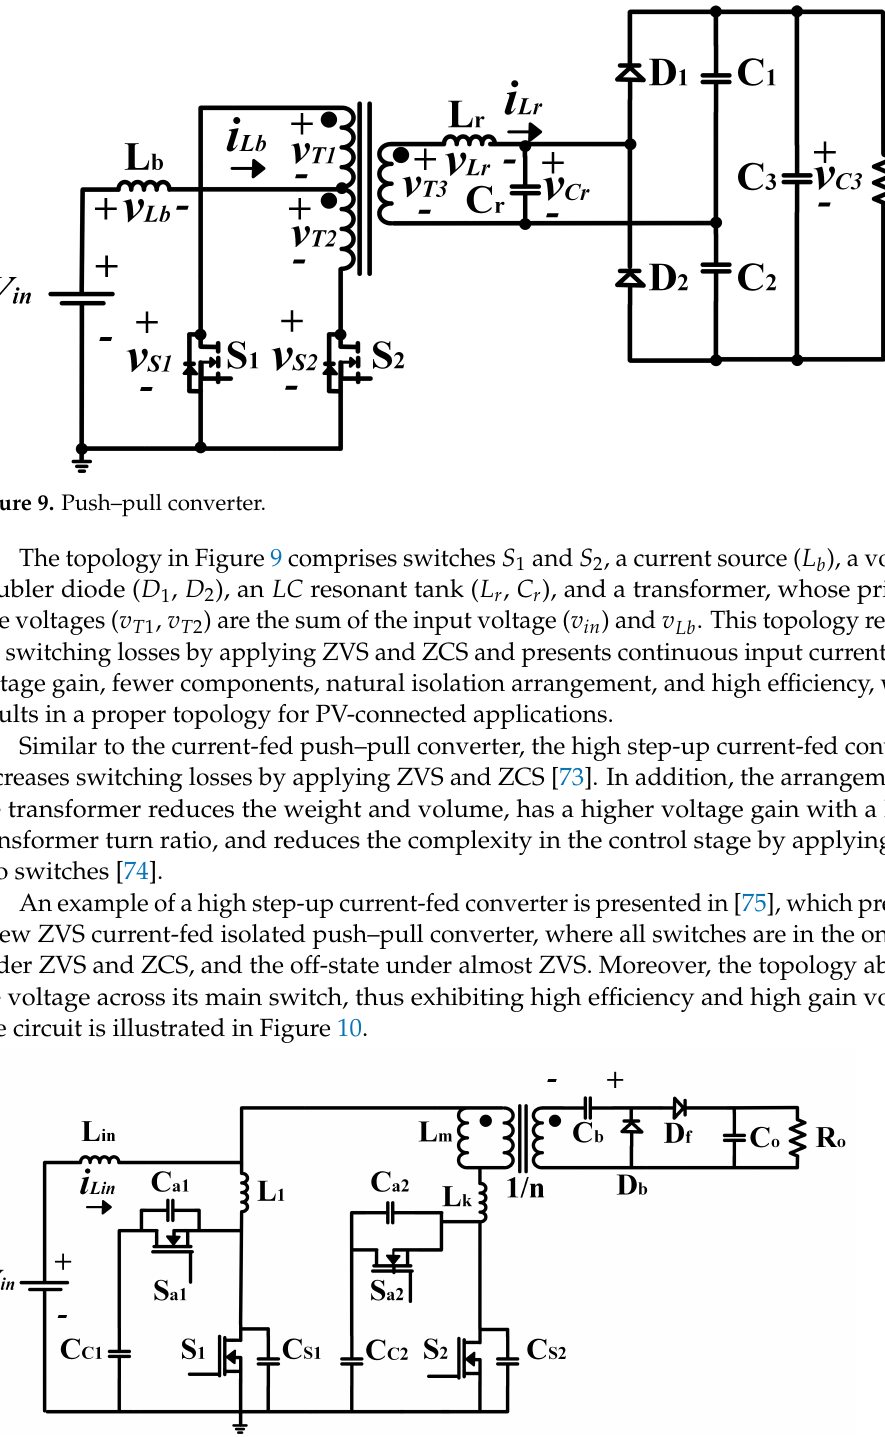
Figure 10. High step-up current-fed